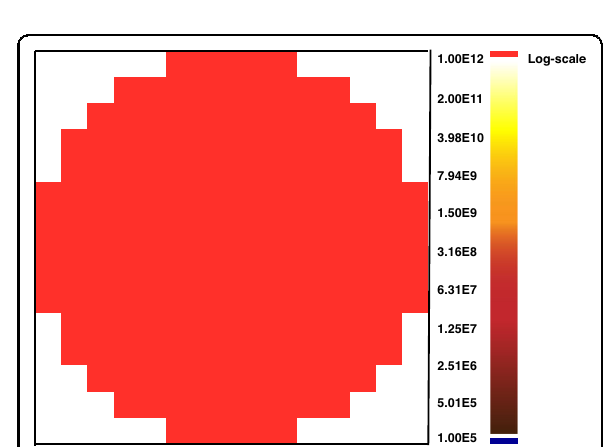
Fig. 10 The resistivity distribution of 6-inch HPSI SiC